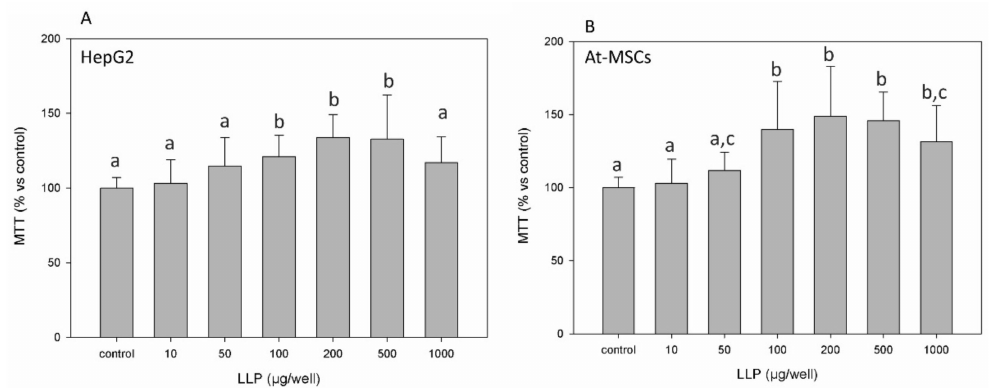
Figure 1. MTT assay on HepG2 and At-MSC cultures after LLP treatment (48 h). ( A ) HepG2: LLP treatment ranging from 100 µ g to 500 µ g/well increased the MTT signal with respect to the control ( p < 0.001). ( B ) At-MSCs: a statistically significant improvement of MTT conversion was observed at concentrations of LLP ranging from 100 µ g to 1000 µ g ( p < 0.001). Absence of a common letter means a statistically significant difference ( p <